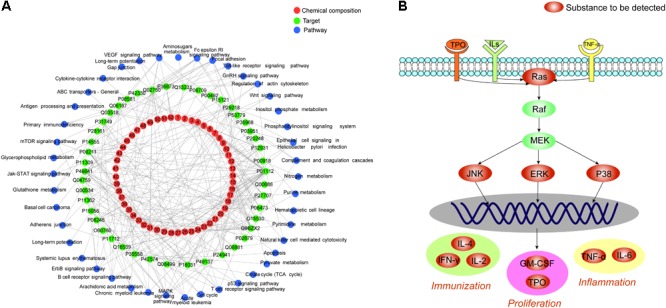
(A) Zi Dian Fang’s “chemical composition-target-pathway” regulatory network. Numbers 1–52 circled in red represent chemical composition, and correspond to data on Figure 1. (B) Identified Ras/MAPKs signaling pathway proteins.